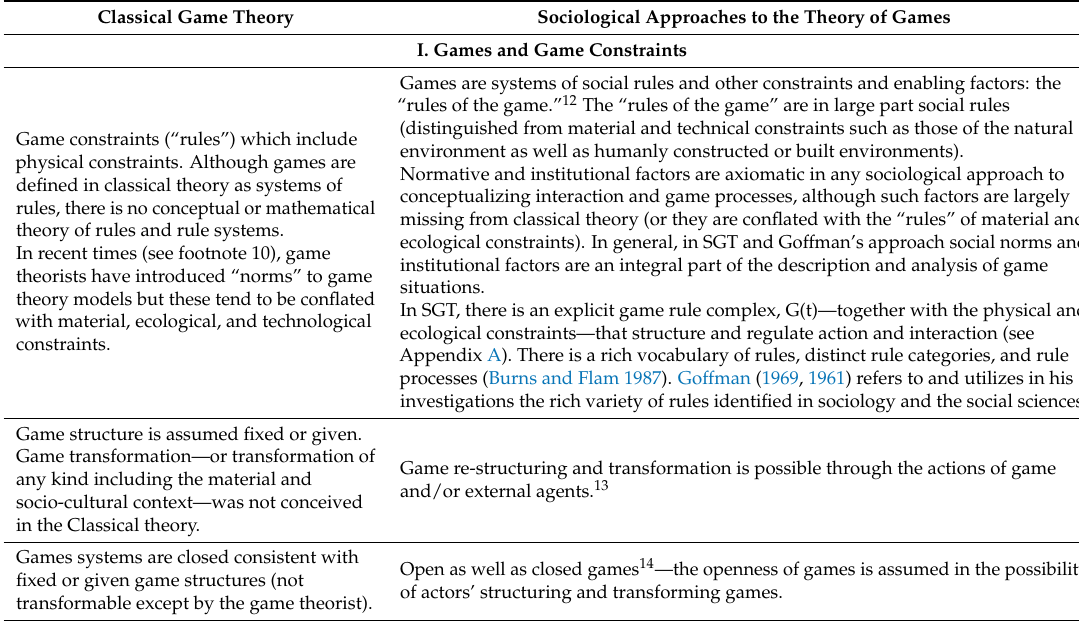
Table 1. Classical and Sociological Game Theories Compared and